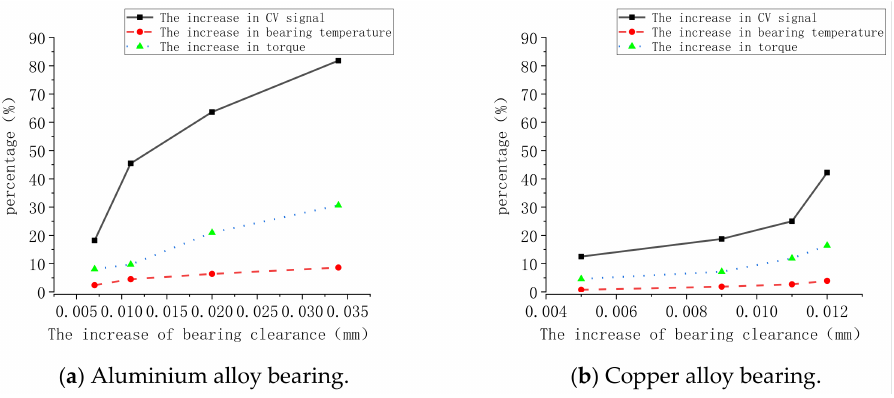
Figure 18. The relationship between wear and